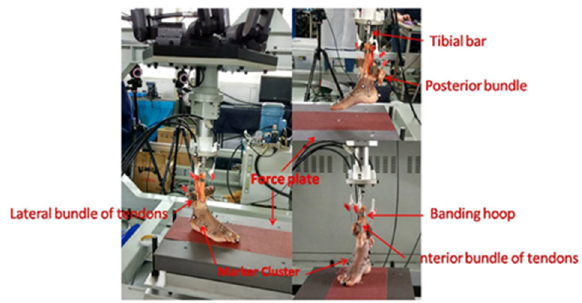
Figure 3. Cadaver foot connected for a simulated gait circle of touchdown, midstance, and toe-off. Reprinted with permission from [23]. Copyright 2022 BMC. Table 1. Recent translational research using foot and ankle robotic systems.